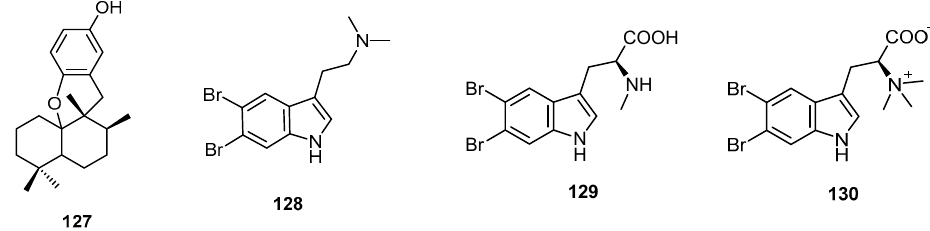
Figure 34. Chemical structures of aureol ( 127 ), N , N -dimethyl-5,6-dibromotryptamine ( 128 ), 5,6-dibromoabrine ( 129 ) and 5,6-dibromo-L-hypaphorine ( 130 ).